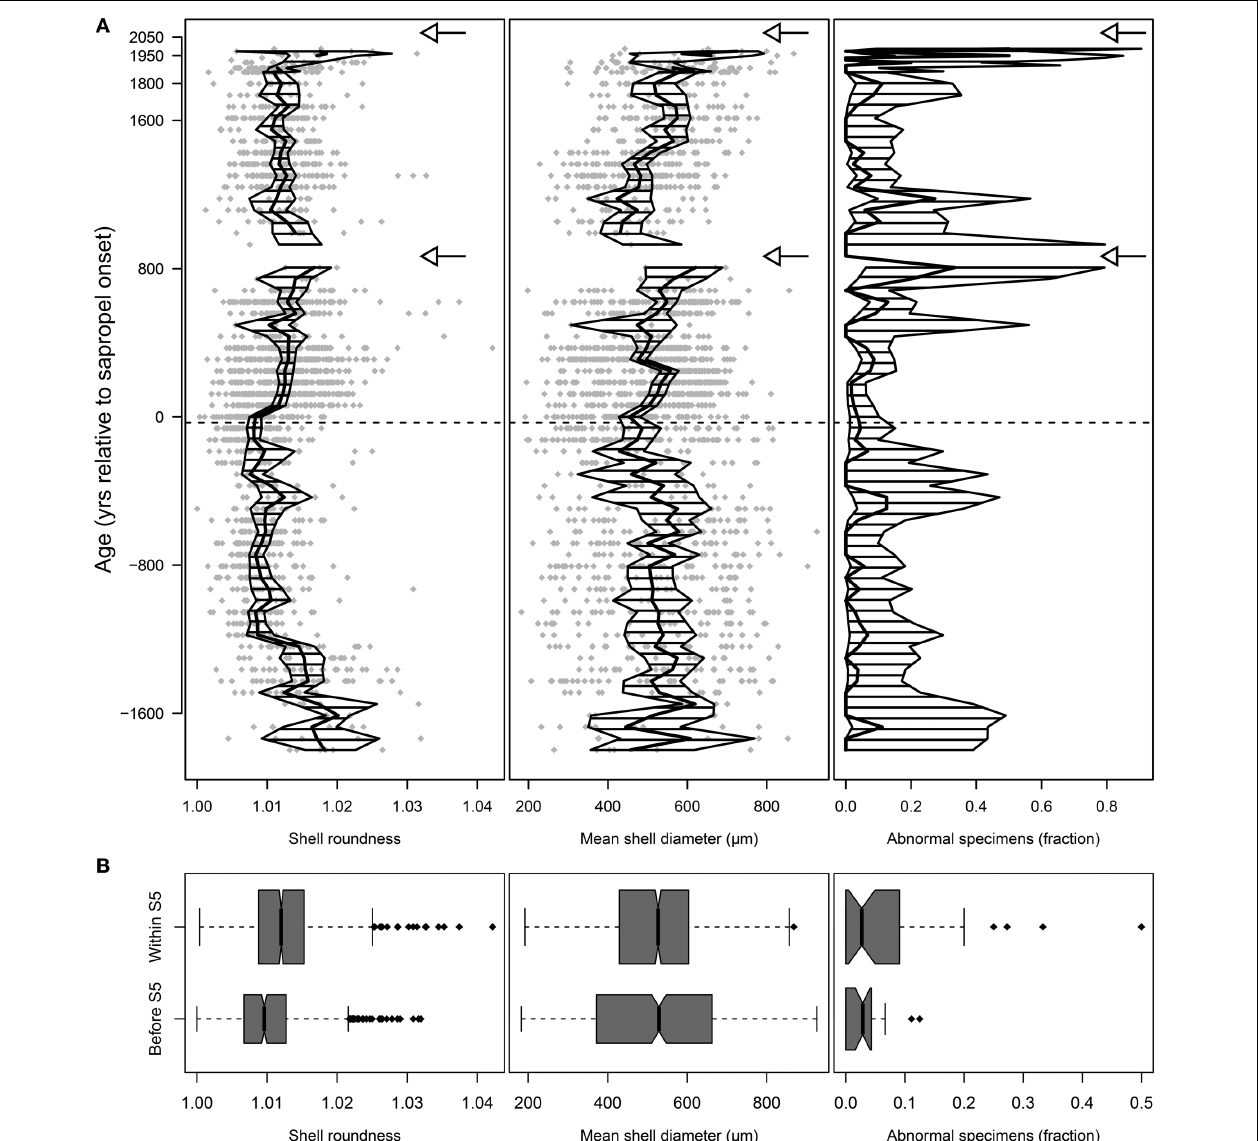
FIGURE 5 | Morphological analyses of shells of Orbulina universa from core M51-3/SL104. Shell roundness is the ratio between long and short axis of the shell, a value of 1.0 representing a perfect sphere. The incidence of abnormal morphotypes combines counts of specimens of the two ecophenotypes “ Biorbulina bilobata ” and “ Orbulina suturalis ,” the arrows mark the local extinctions of the species. (A) Stratigraphic plots depicting the raw values for shell roundness and diameter (gray diamonds), the arithmetic mean values (thick black line), and the 95% confidence intervals of the mean